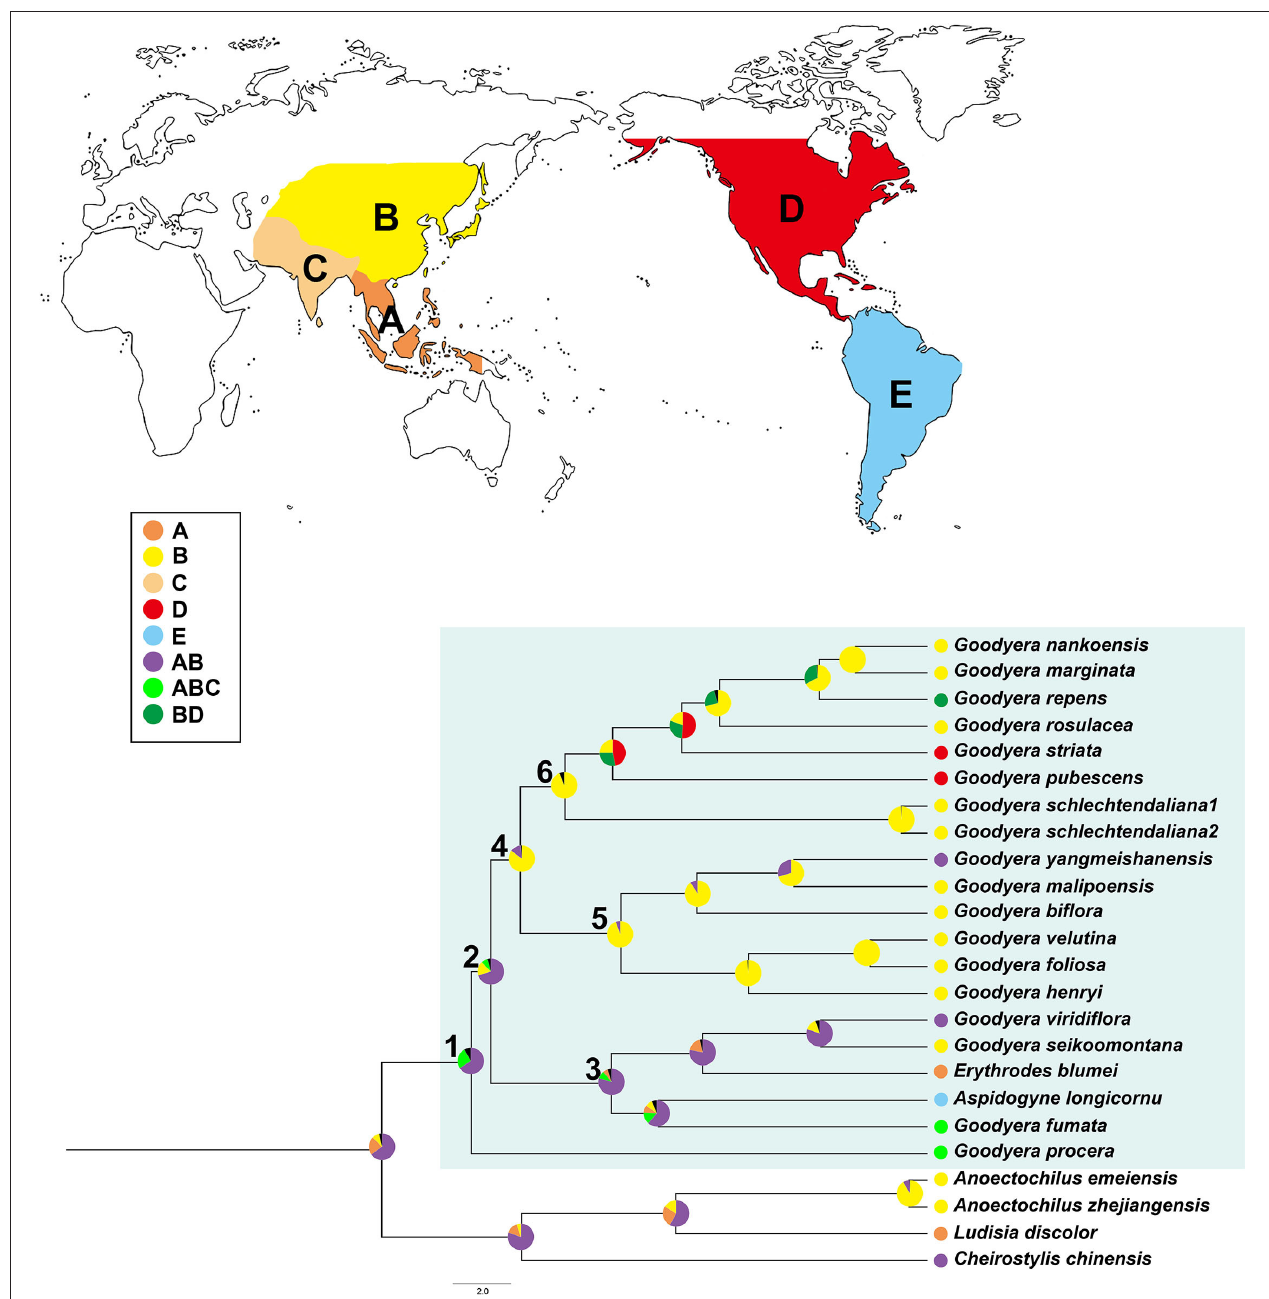
FIGURE 5 | Summary of Bayesian binary method (BBM) model of ancestral area reconstruction in Goodyera based on a reduced BEAST combined-gene chronogram. The BBM ancestral area reconstructions with the highest likelihood are shown as pes for each clade of Goodyera . Biogeographical regions are used in BBM: A, Southeast Asia; B, East Asia; C, South Asia; D, North America; E, South America. Blue box = Goodyera clade. Numbers 1–6 indicate nodes of interest (for details, refer to Table 3